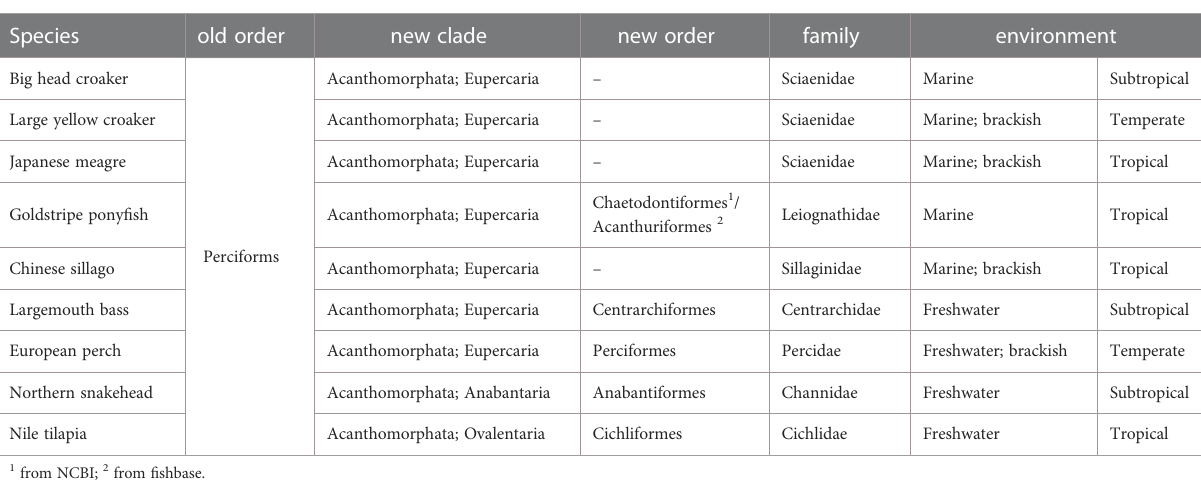
TABLE 1 Info of 9 Ex-perciforms.